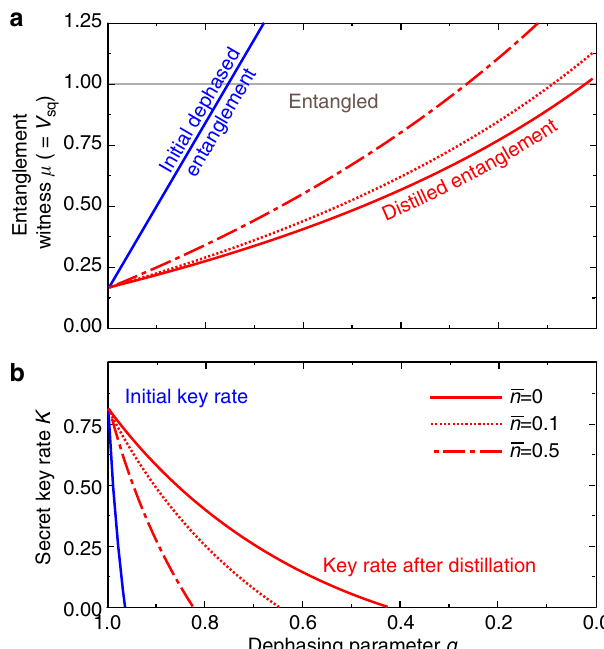
Figure 3 | Entanglement distillation of phase-diffused two-mode- squeezed states. Squeezing variance V sq ( a ) and distillable secret key K ( b ) are plotted for the phase-diffused state (blue) and for the asymptotic distilled state for different (cid:2) n (red lines). (cid:2) n gives here the mean number of thermal photons of the state we project onto. The parameter q quantifies the strength of the phase diffusion: q ¼ 1 indicates that no phase noise is present, whereas q ¼ 0 corresponds to a completely randomized phase. The parameters of the input state before phase-diffusion read a ¼ 3.583 and b ¼ 3.417, which corresponds to variances of squeezed and anti-squeezed quadratures V sq ¼ 1/6 and V antisq ¼